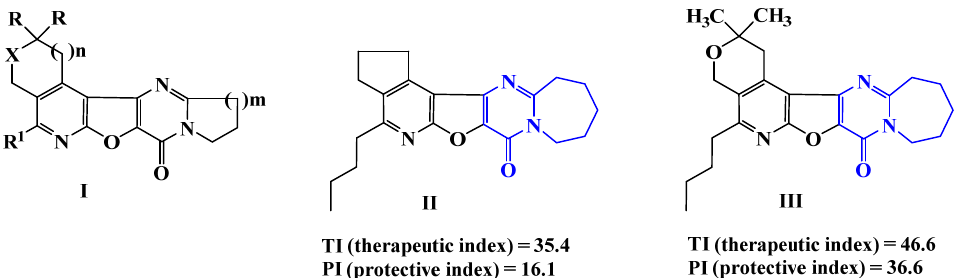
Figure 1. General I and lead structure II , III of compounds from our previous study. I . X = CH 2 , O; R = H, Me; n = 0, 1; R 1 = alkyl, aryl; m = 1, 3.